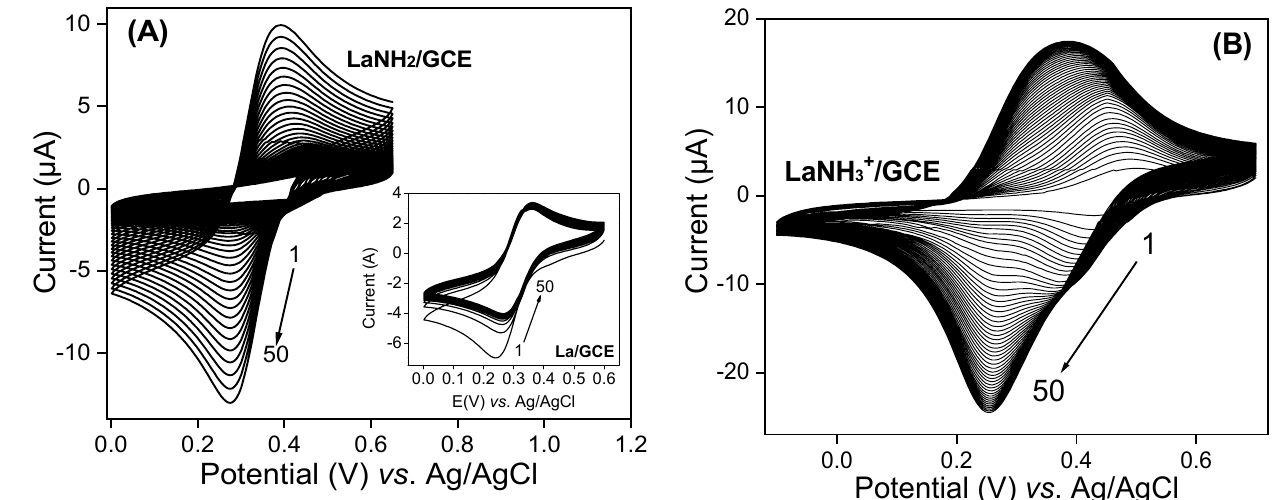
Figure 4. Multisweep cyclic voltammograms recorded in 10 − 2 M HCl containing 5 × 10 − 4 M (Fe(CN) 6 ) 3 − on a glass carbon electrode (GCE) modified with ( A ) LaNH 2 and ( B ) LaNH 3+ materials. The inset in Figure 4A represents the same experiment on the GCE covered by a thin film of unmodified La.